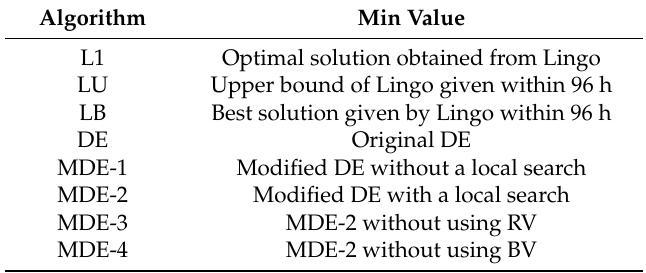
Table 12. Definitions of Lingo v.11 solutions and the proposed